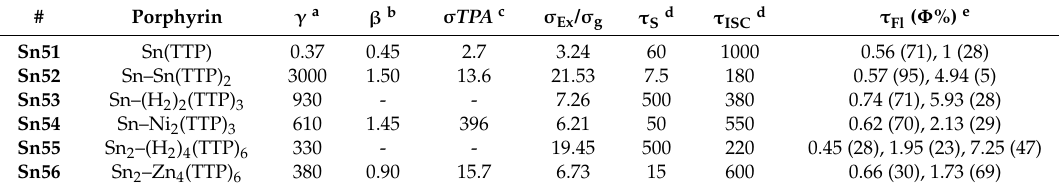
Table 6. Optical properties of the oligomers described by Rao and Kiram et al. [89,90].